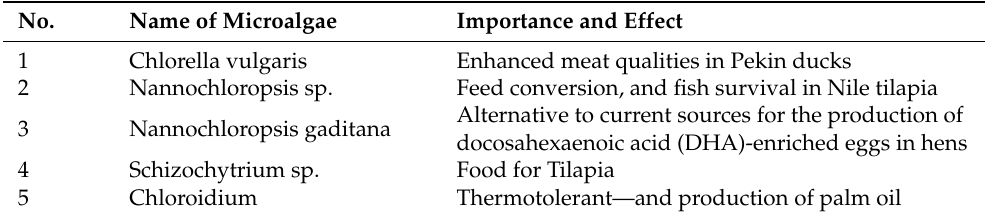
Figure 10. Algae biomass cultivation and its utilization for shrubbery forests and landscaping in WD valley. Table 2. Types, importance, and effect of microalgae used as aquatic and animal feed [74]. No.